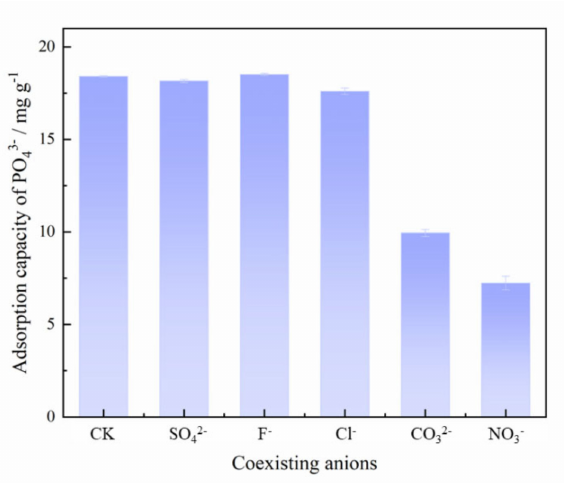
Figure 6. Effect of coexisting anions on phosphorus removal